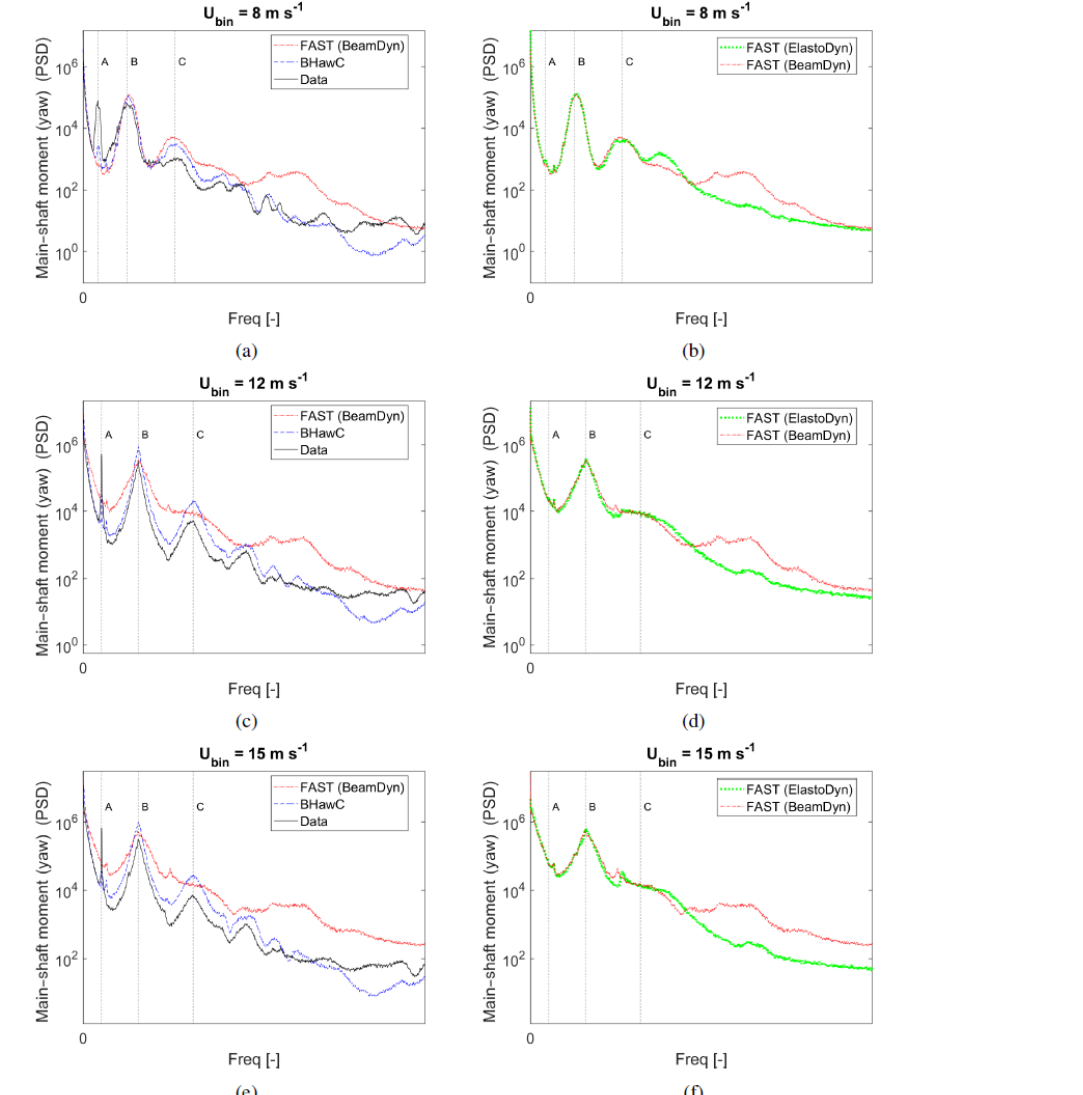
Figure 19. PSDs of the main-shaft bending moment – yaw (nonrotating coordinate system). The three sets of graphs represent the ensemble- averaged PSDs from the inflow velocity bins at 8ms − 1 (top), 12ms − 1 (center), and 15ms − 1